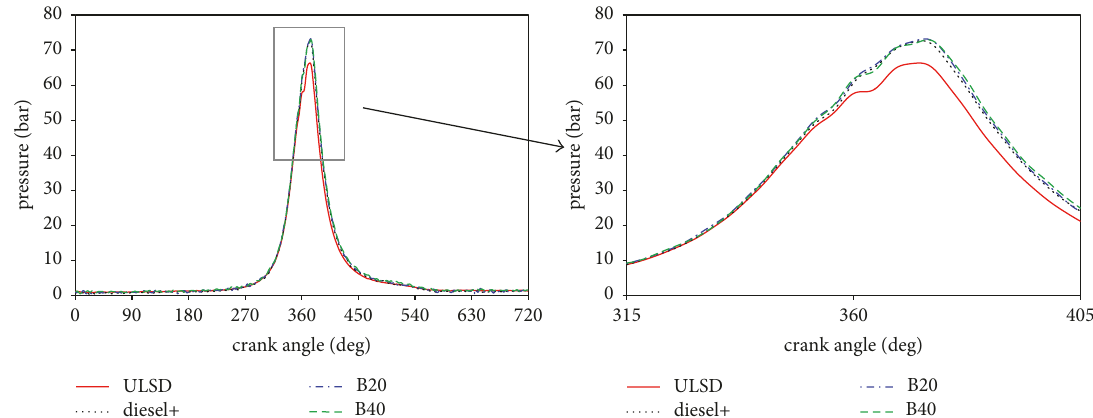
Figure 5: Variation of in-cylinder pressure with engine speed at 3000 rpm and 80% load (18 Nm).